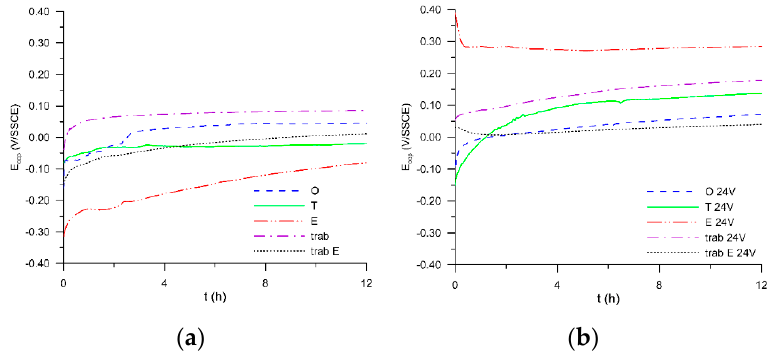
Figure 3. The open-circuit potential of specimens in physiological solution: ( a ) surfaces without anodization, ( b ) anodized surfaces.